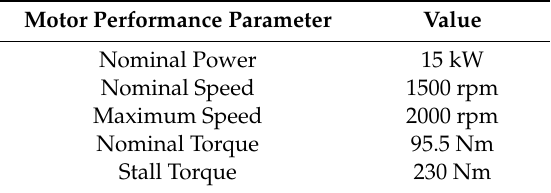
Table 3. Features of the considered electric motor.